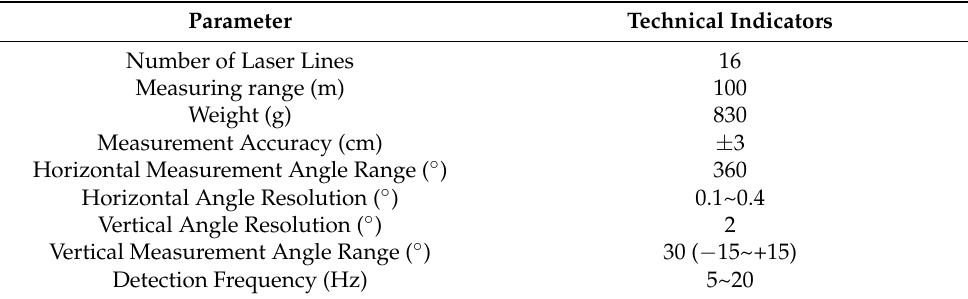
Table 2. LiDAR main parameters and technical